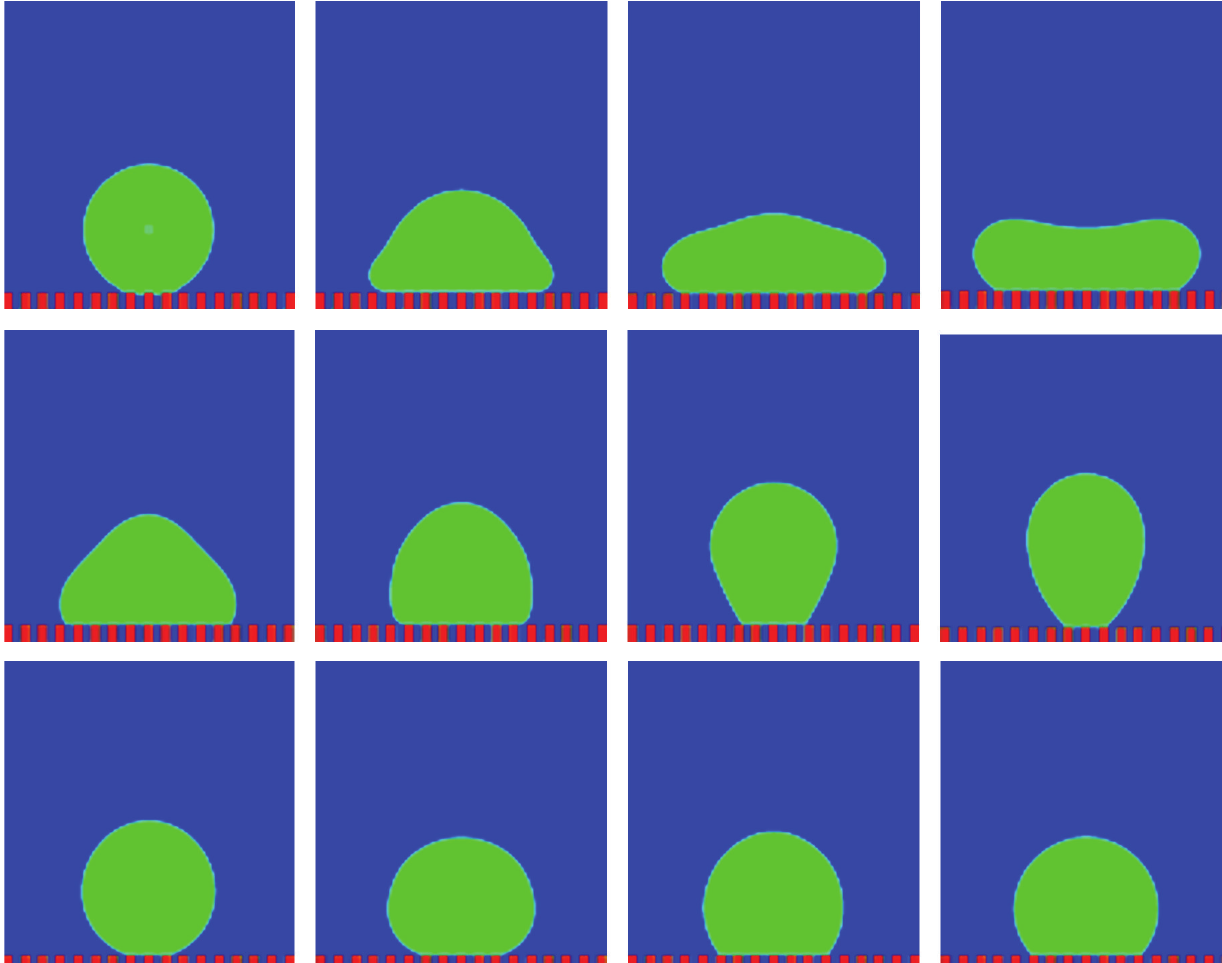
Figure 5: The dynamic behaviors of droplet impacting on hydrophobic surface (CA = 119.3 ∘